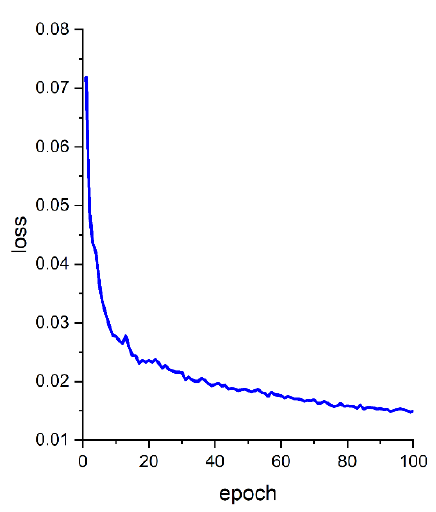
Figure 13. GIoU loss function mean value plot.